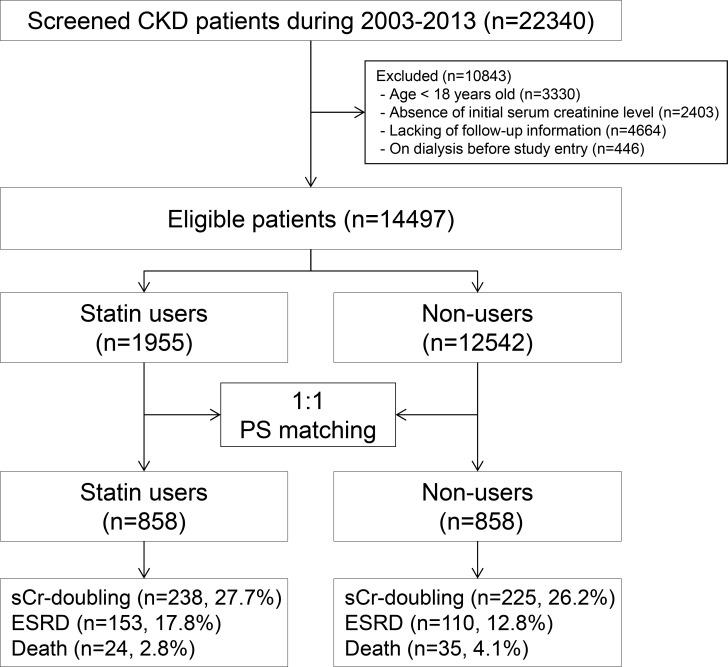
Cohort formation.